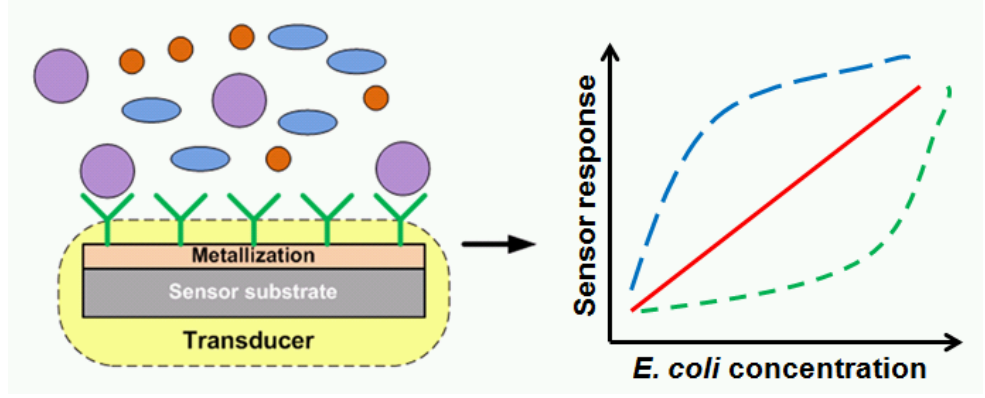
Figure 1. Schematic image of biosensor ’ s mechanism.